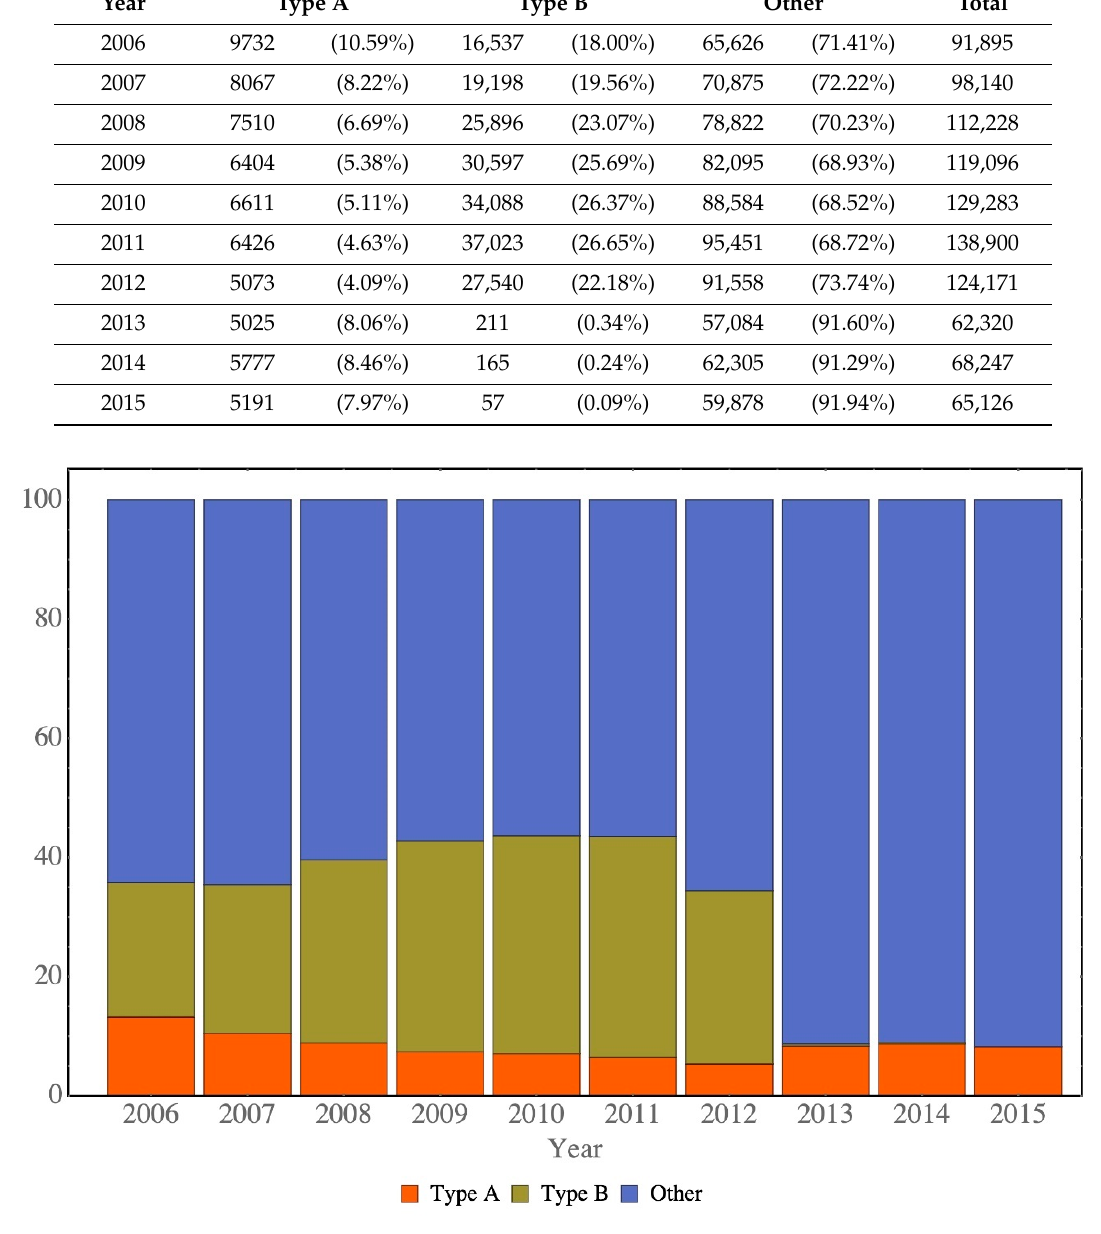
Table 1. Breakdown of numbers of various types of children who returned to Hong Kong in different years.